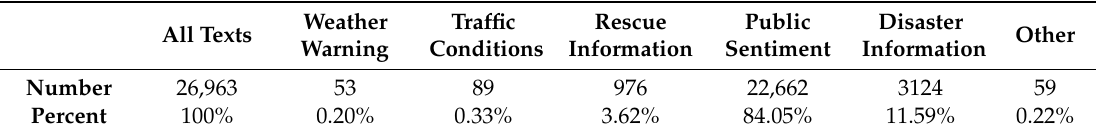
Table 1. Classification statistics of Weibo under different topics.